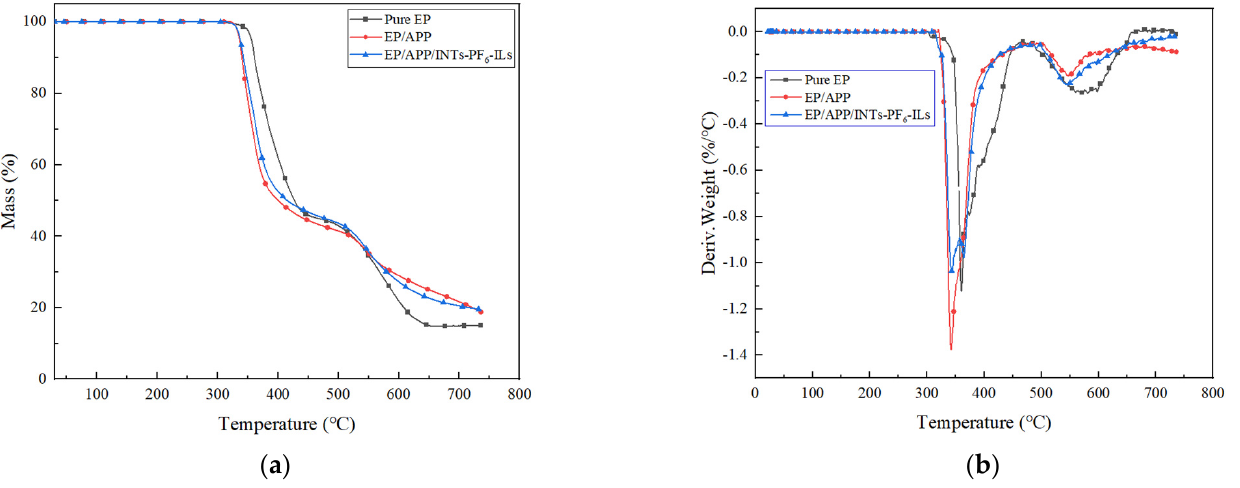
Figure 1. ( a ) TGA curves of EP composites; ( b ) DTG curves of EP composites. Table 3. Thermogravimetric analysis data of EP